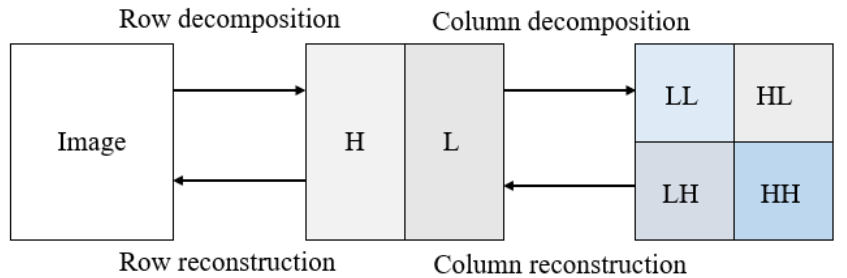
Figure 5. The process of wavelet decomposition and reconstruction.